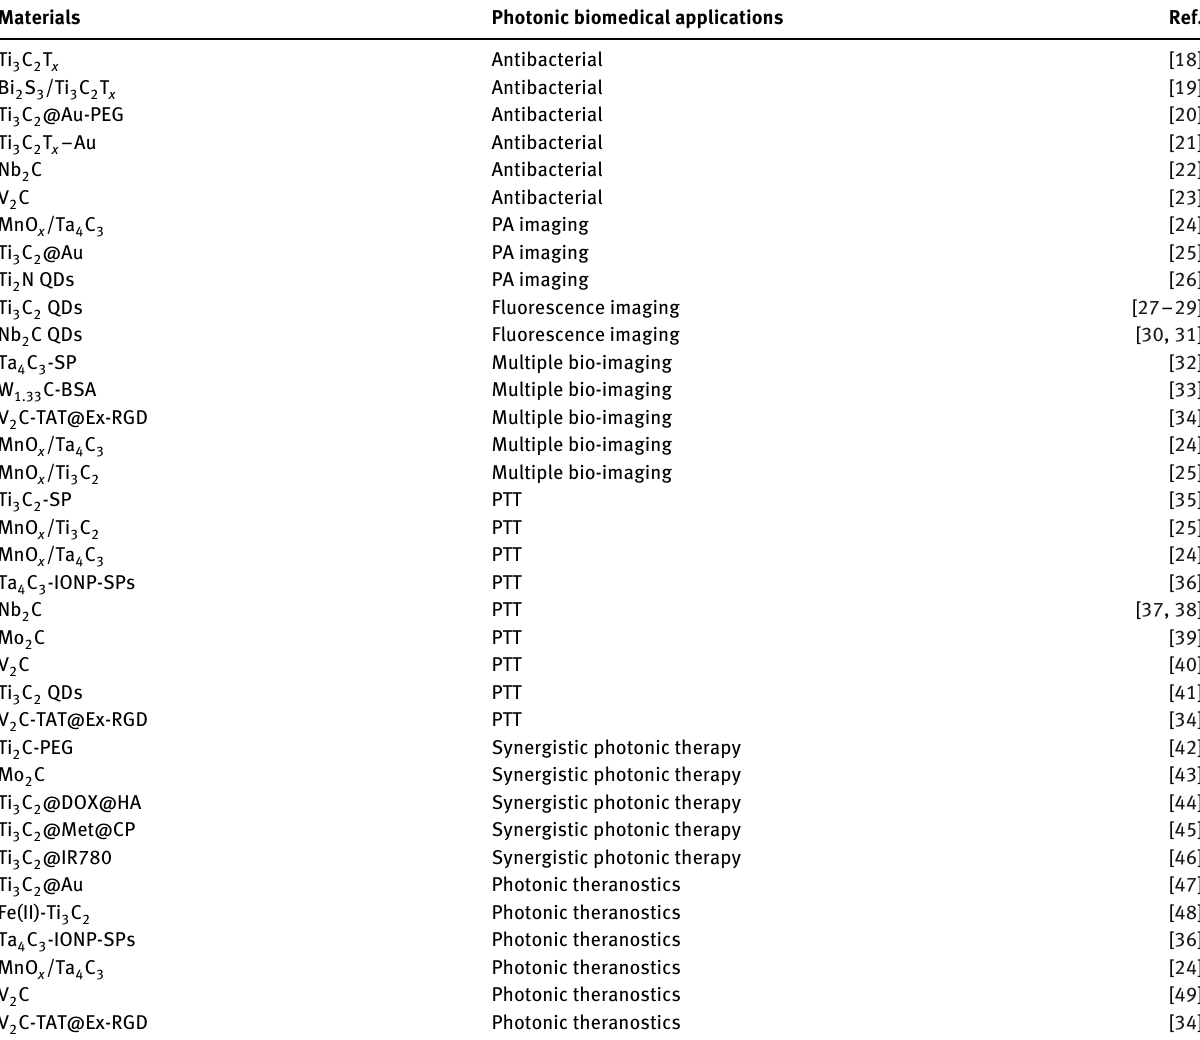
Table 1: Summary of photonic biomedical applications of 2D MXenes. Materials Photonic biomedical applications